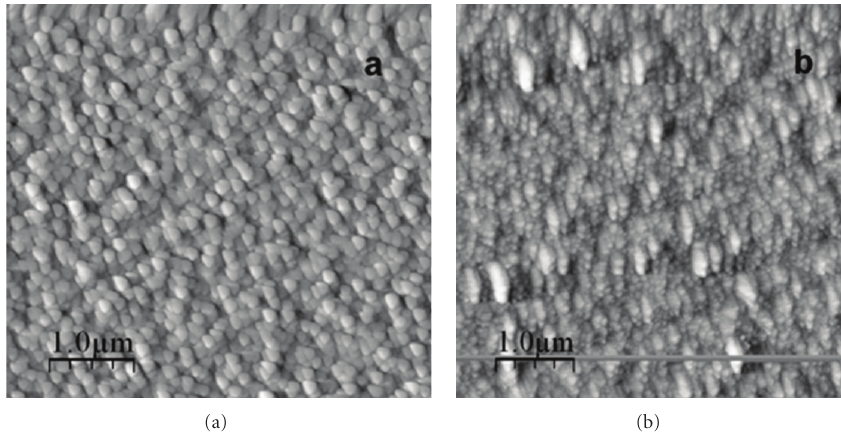
Figure 5: Topographical images (5 μ m × 5 μ m) of dc (a) and rf (b) sputtered Mo deposited at 4mTorr Ar pressure.